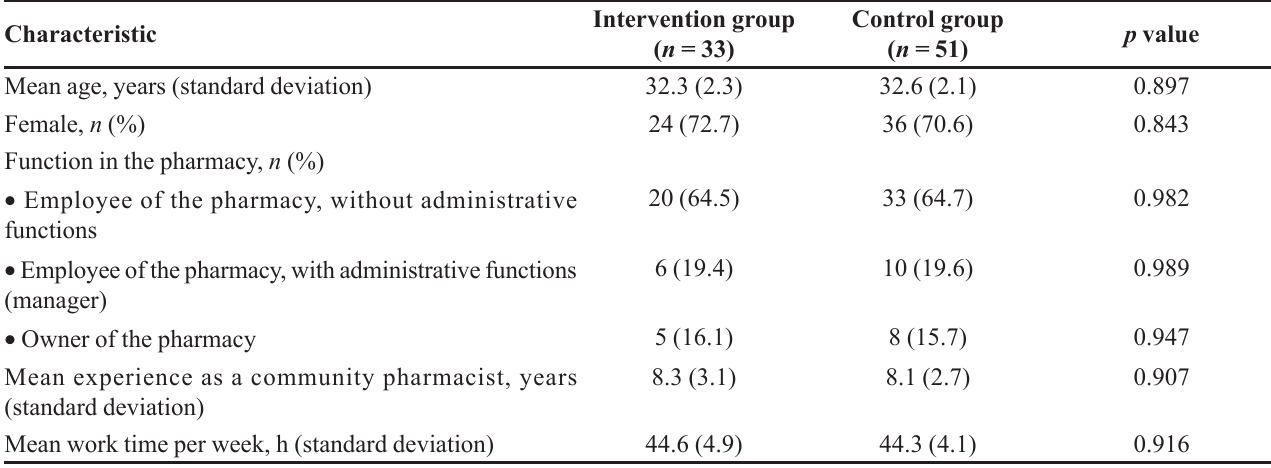
TABLE I - General characteristics of the community pharmacists who participated in the study Characteristic